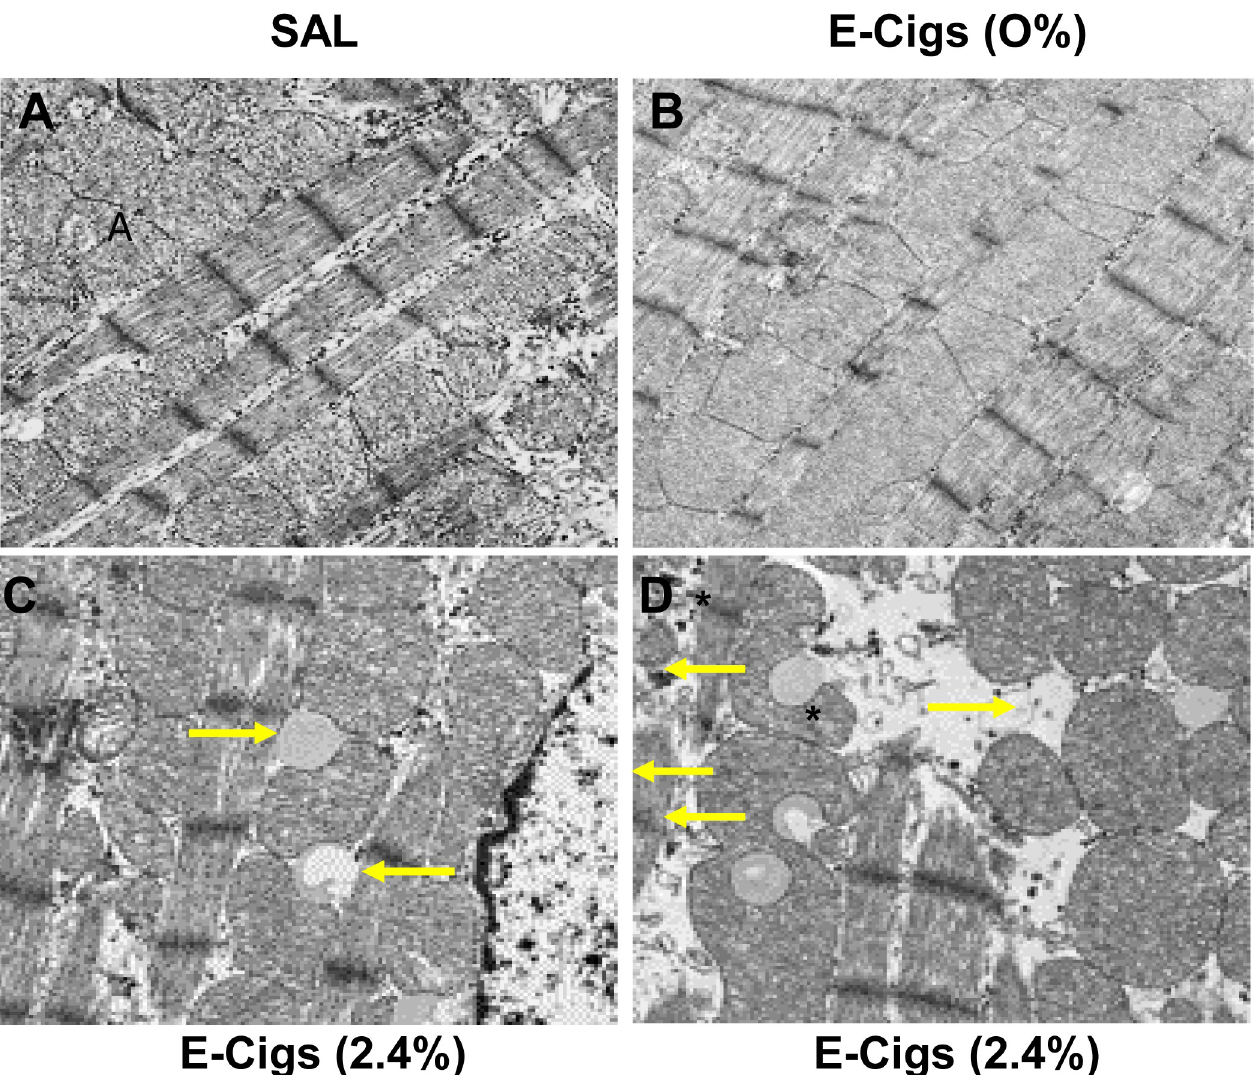
Fig 2. E-cigarette (2.4% nicotine) plus HFD induces left ventricular ultrastructural abnormalities in obese mice. ( A-D ) Representative TEM images of left ventricular myofibrillar architecture in various treatment groups. CMs from saline-( A ) or e-cigarette (0% nicotine)-exposed ( B ) mice on an HFD shows normal myofibrillar architecture and sarcomeric pattern with normal nuclei and abundant mitochondria (m). In contrast, CMs from e-cigarette (2.4% nicotine) plus HFD exposed mice shows varying degrees of abnormalities ( C, D ), indicative of cardiomyopathy, including ventricular intramyocardial lipid accumulation (yellow arrow) or ventricular steatosis ( C, D ), myofibrillar derangement, thinning, and destruction (asterisks), and mitochondrial hypertrophy ( C, D ). Scale bar = 1 μ